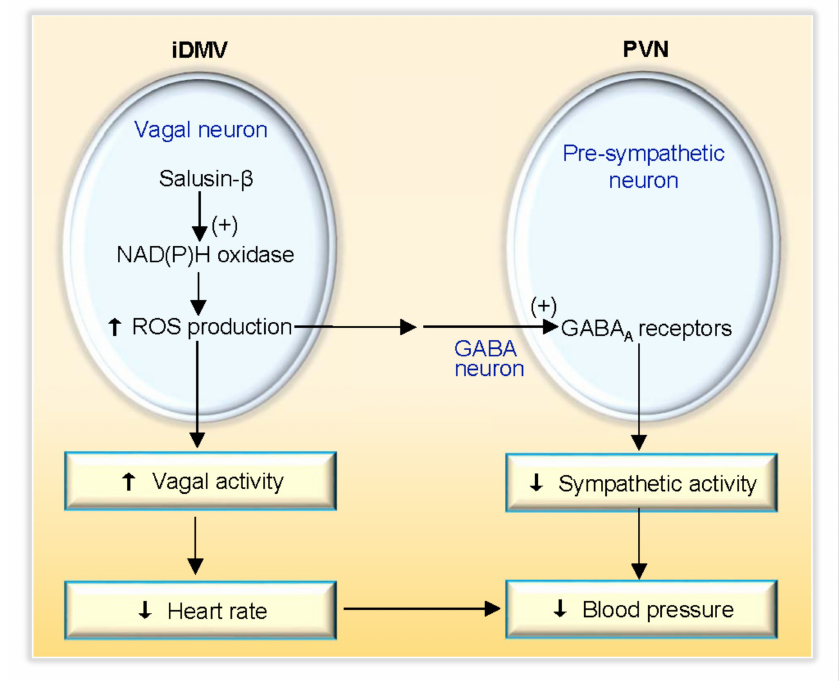
Figure 8. Schematic diagram showing the roles of salusin- β in iDMV and its downstream signal pathway. In conclusion, salusin- β in the iDMV inhibits sympathetic activity and enhances vagal activity, and thereby reduces blood pressure and heart rate. The effect of salusin- β on vagal activation is mediated by NAD(P)H oxidase activation-dependent superoxide anion production in the iDMV. The effect of salusin- β on sympathetic inhibition is mediated by NAD(P)H oxidase-originated superoxide anion production in the iDMV and the following GABA A receptor activation in the PVN. Endogenous salusin- β and ROS production in the iDMV play a tonic role in inhibiting sympathetic activity. The findings reveal the novel mechanism for the central regulation of sympathetic-parasympathetic